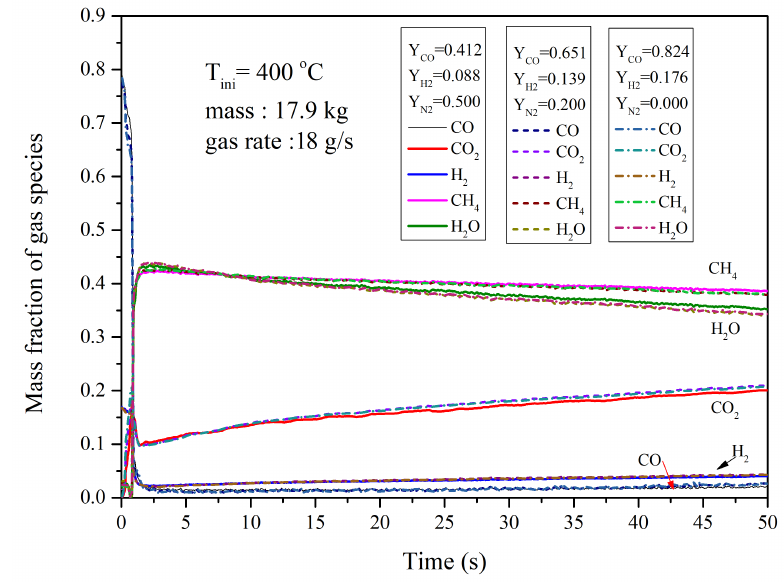
Figure 20. Time evolution of gas species mass fraction under different temperatures. Gas inlet rate is 0.018 kg/s. Solid inventory is 17.9 kg. N 2 is used as balance